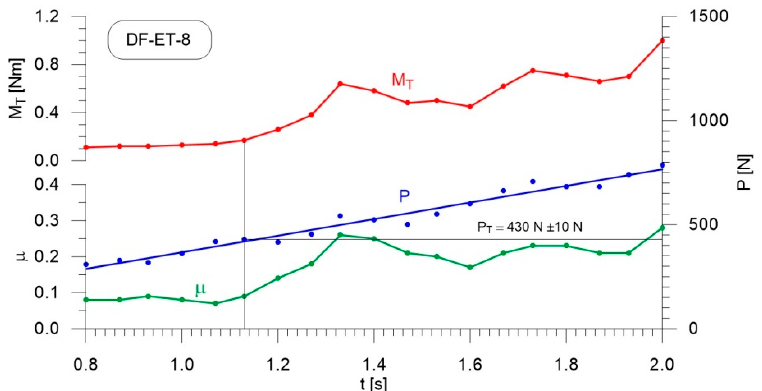
Figure 7. Courses of the load, P, the friction torque, M T , and the friction coefficient, µ, for diesel–ethanol blend with a 6% ethanol volume fraction.